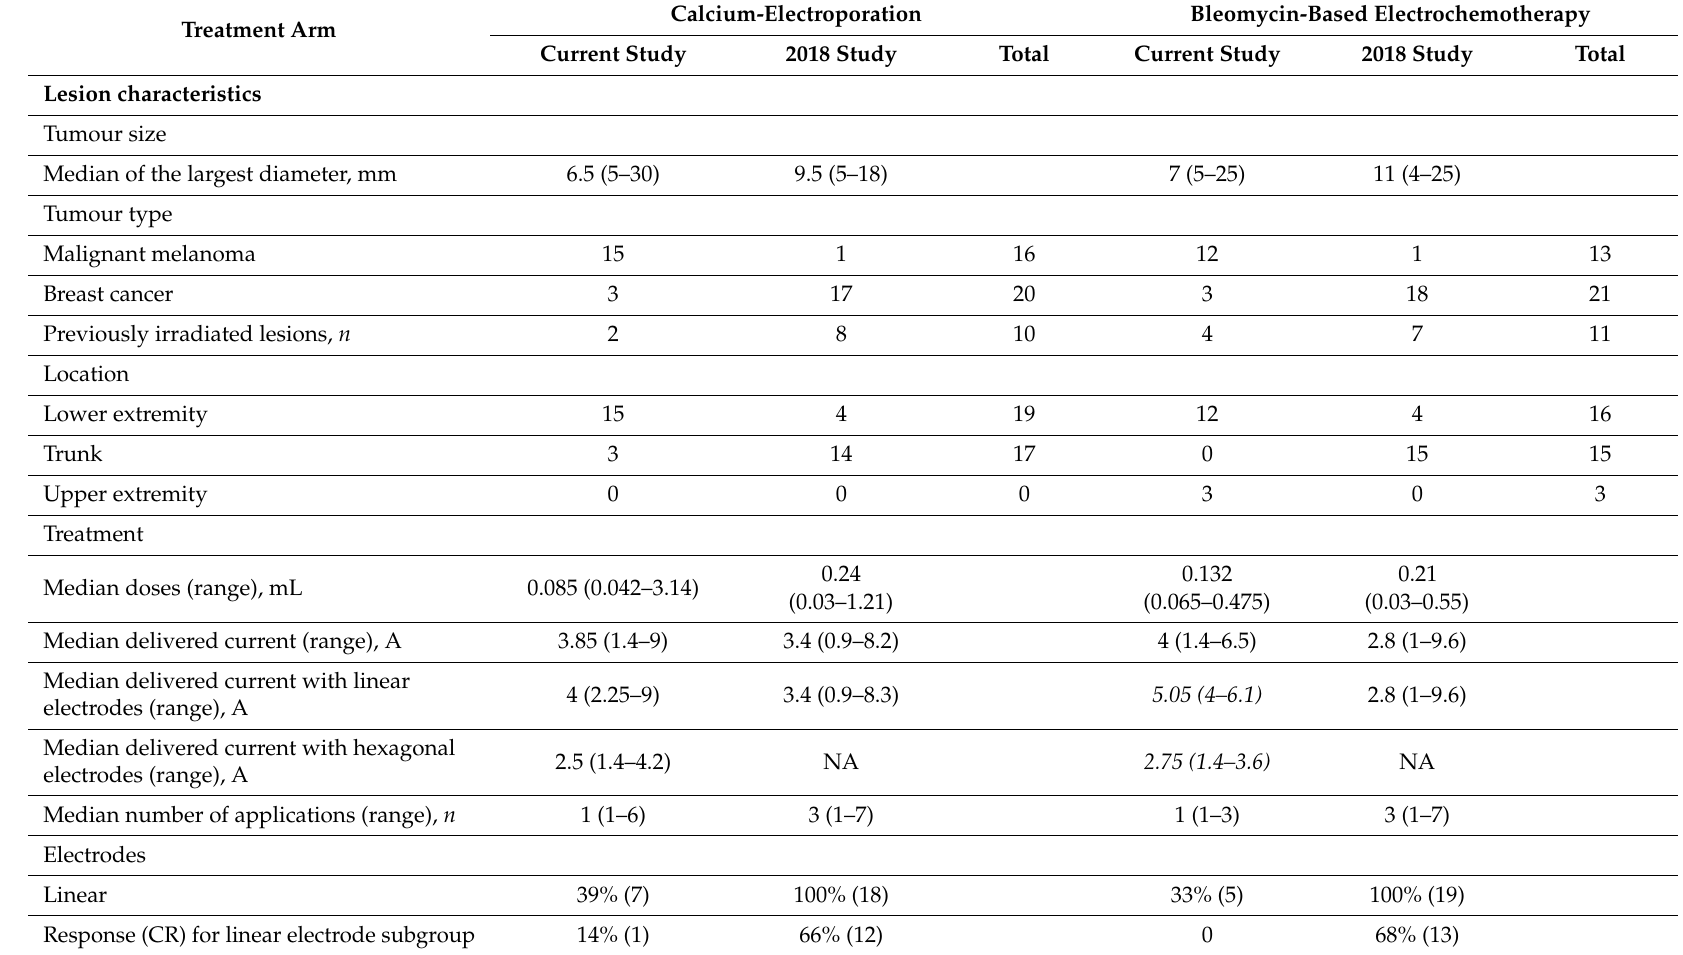
Table 2. Results of the current study in comparison with the study published in